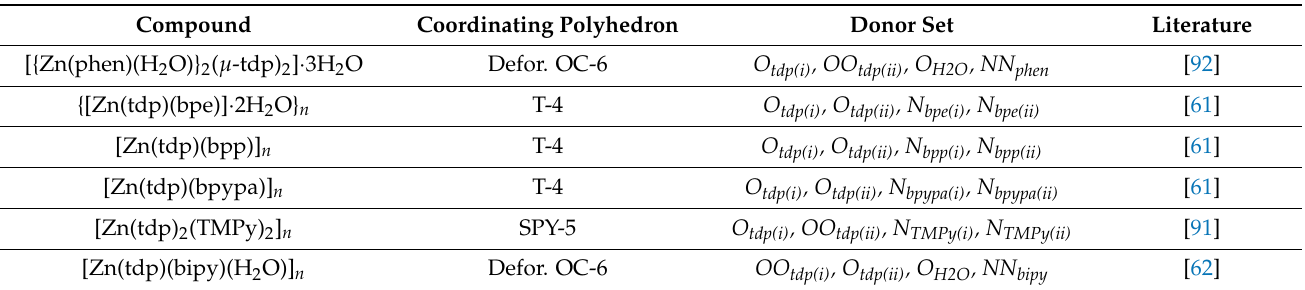
Table 6. Summary of Zn(II) coordination compounds prepared and structurally characterized so far with 3,3 1 -thiodipropionic acid and N donor